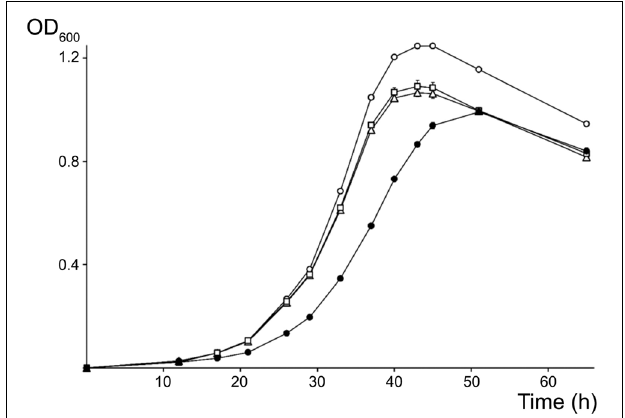
FIGURE 2 | Growth curves for NGR234 and the rRNA-deletion mutants. Evolution of the growth of NGR234 (O), NGR (cid:49) rRNA1 ( (cid:49) ), NGR (cid:49) rRNA3 ( (cid:3) ), and NGR (cid:49) rRNA1,3 ( ) strains in liquid RMS cultures at 27 ◦ C and with orbital shaking. Error bars indicate the standard deviation of the mean, with three (cid:32) independent cultures grown in parallel for each